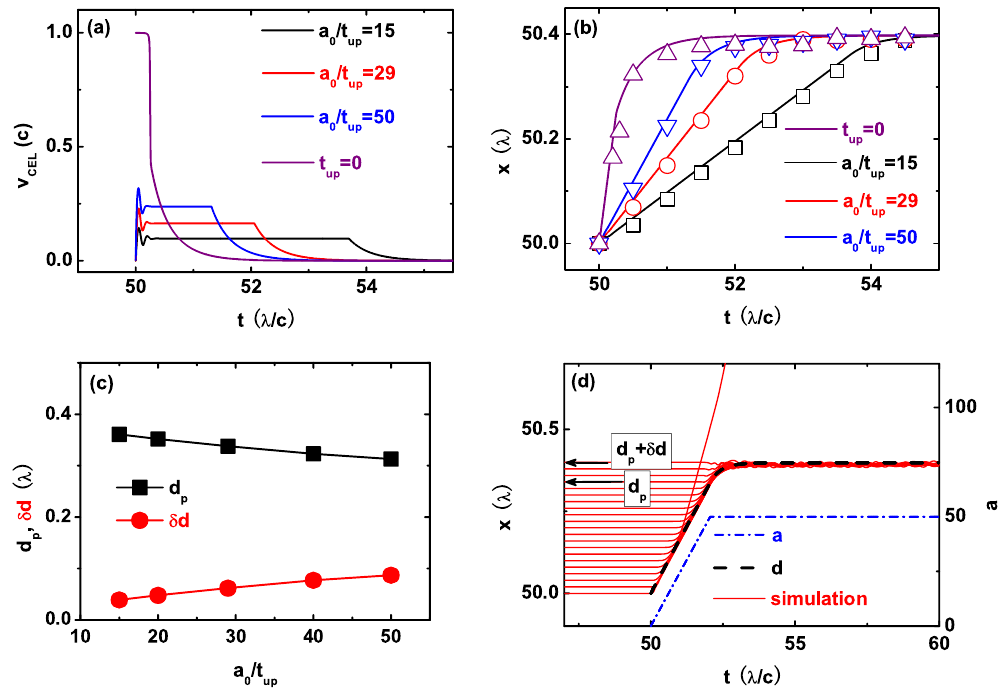
FIG. 3. (a) Velocity of the CEL v CEL for different laser-front steepness a 0 =t up ¼ 15 (black), 29 (red), 50 (blue), and 1 ( t up ¼ 0 T ) (purple) from the analytical model. (b) CEL positions from the analytical model (solid lines) and simulation (point symbols). (c) Relaxation distance (cid:11)d and the CEL position when the laser peak a 0 reaches d p versus a 0 =t up . Here n 0 ¼ 40 n c , l 0 ¼ 0 : 5 (cid:3) , and a 0 ¼ 50 . (d) CEL positions d (dashed line) and incident laser amplitudes on the CEL surface a (dash dotted line) from the analytical model and electron trajectories (solid lines) from the simulation for n 0 ¼ 40 n c , l 0 ¼ 0 : 4 (cid:3) , and a 0 =t up ¼ 29 ( a 0 ¼ 50 and t ¼ 1 : 72 T up